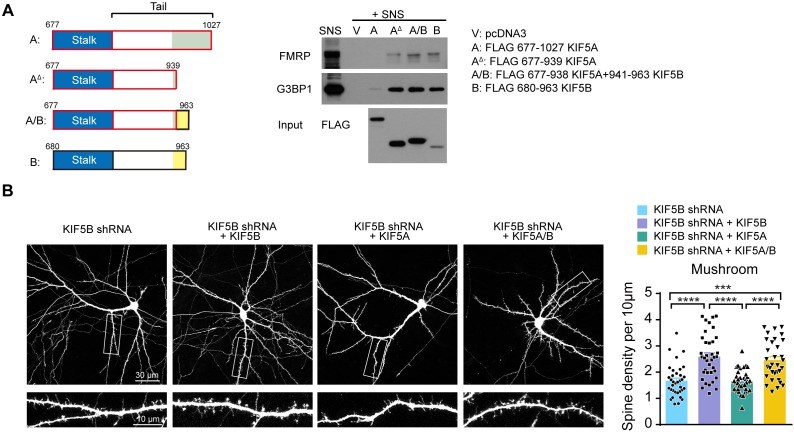
Carboxyl-terminus determines the functional specificity of KIF5A and KIF5B in dendritic spine morphogenesis.(A) Schematic diagram of the different constructs for pull-down assay (left panel). FMRP and G3BP1 were pulled-down from the SNS by either the truncated KIF5A lacking the 88 amino acids at the carboxyl-terminus, or chimeric KIF5A/B in which the carboxyl-terminus was substituted by that of KIF5B (right panel). (B) Representative images of dissociated rat hippocampal neurons co-transfected with GFP and KIF5B-shRNA with/without KIF5B, KIF5A or chimeric KIF5A/B containing the carboxyl-terminus of KIF5B (1–938 KIF5A+941–963 KIF5B). Co-expression of chimeric KIF5A/B rescued the loss of mushroom spines induced by KIF5B-shRNA (32–37 neurons of each group from three independent experiments were quantified; mean + SEM; ***p<0.001, ****p<0.0001; Kruskal-Wallis test).
Figure 4—source data 1.Plotted values for Figure 4.